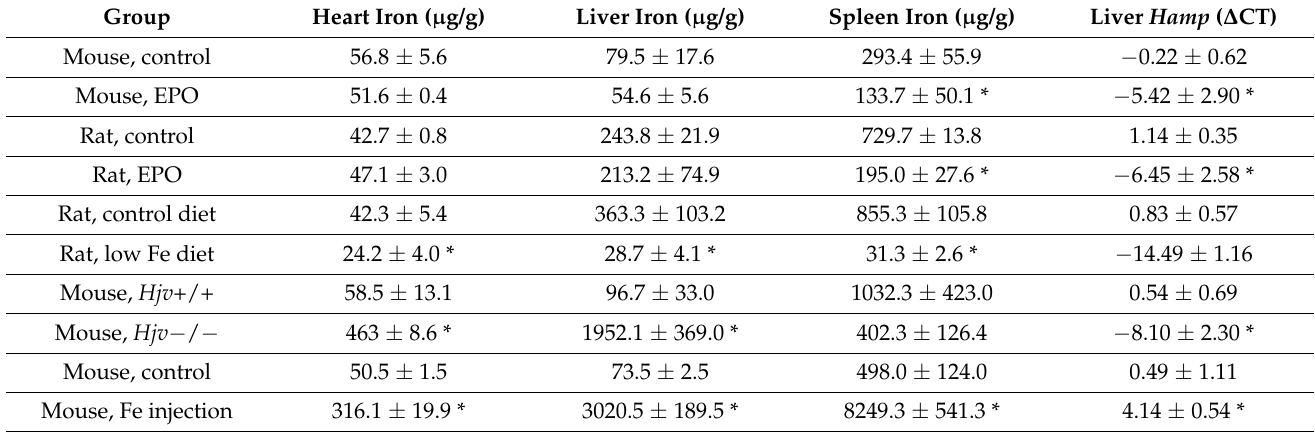
Table 1. Iron content and liver hepcidin expression in the experimental groups